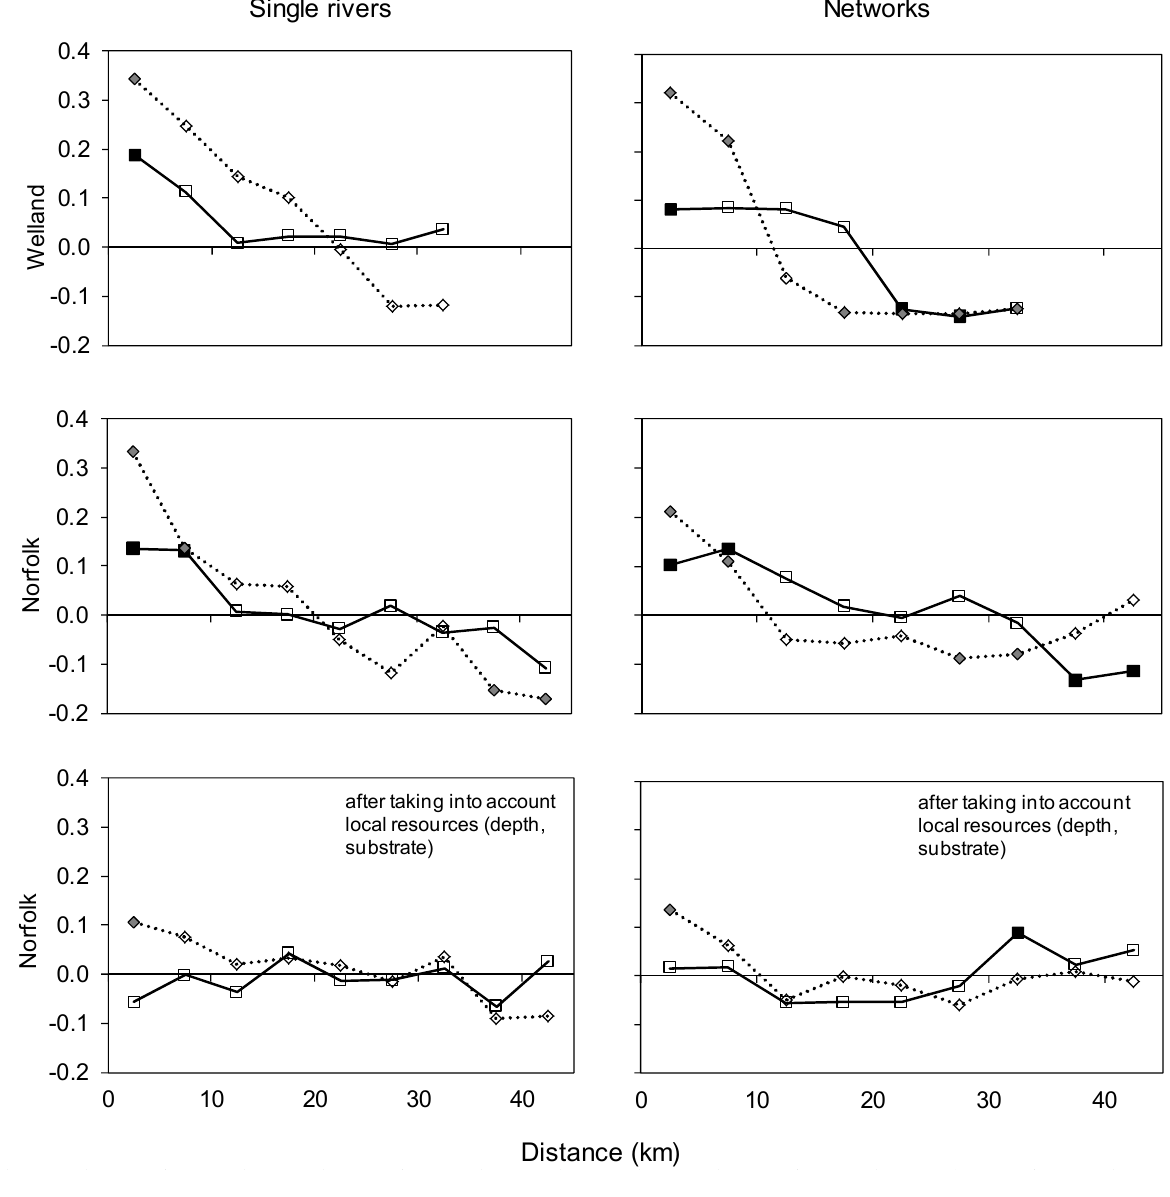
Figure 13. Spatial autocorrelation in species composition along rivers and across networks based on log transformed abundance data (square symbols, black line) and presence-absence data (diamond symbols, dashed line). Significant tests are indicated by a filled symbol (after progressive Bonferroni correction of α = 0.05/k for the kth distance class). Positive Mantel statistics represent positive autocorrelation. Mantel statistics range from − 1 to 1. Number of comparisons per class was relatively low for the rivers Welland (13–21) and Wensum (20–47) and relatively high for the network analyses (Welland 30–245, Norfolk